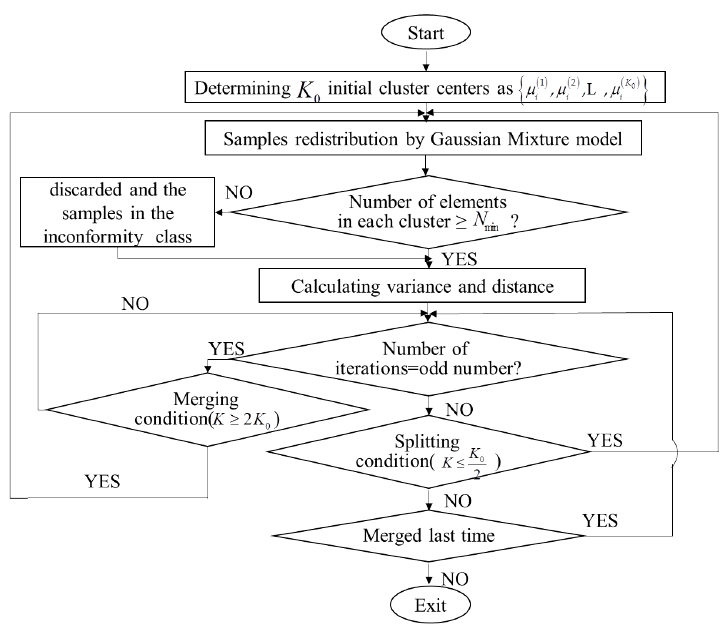
Figure 2. Flow chart of the ISODATA model.